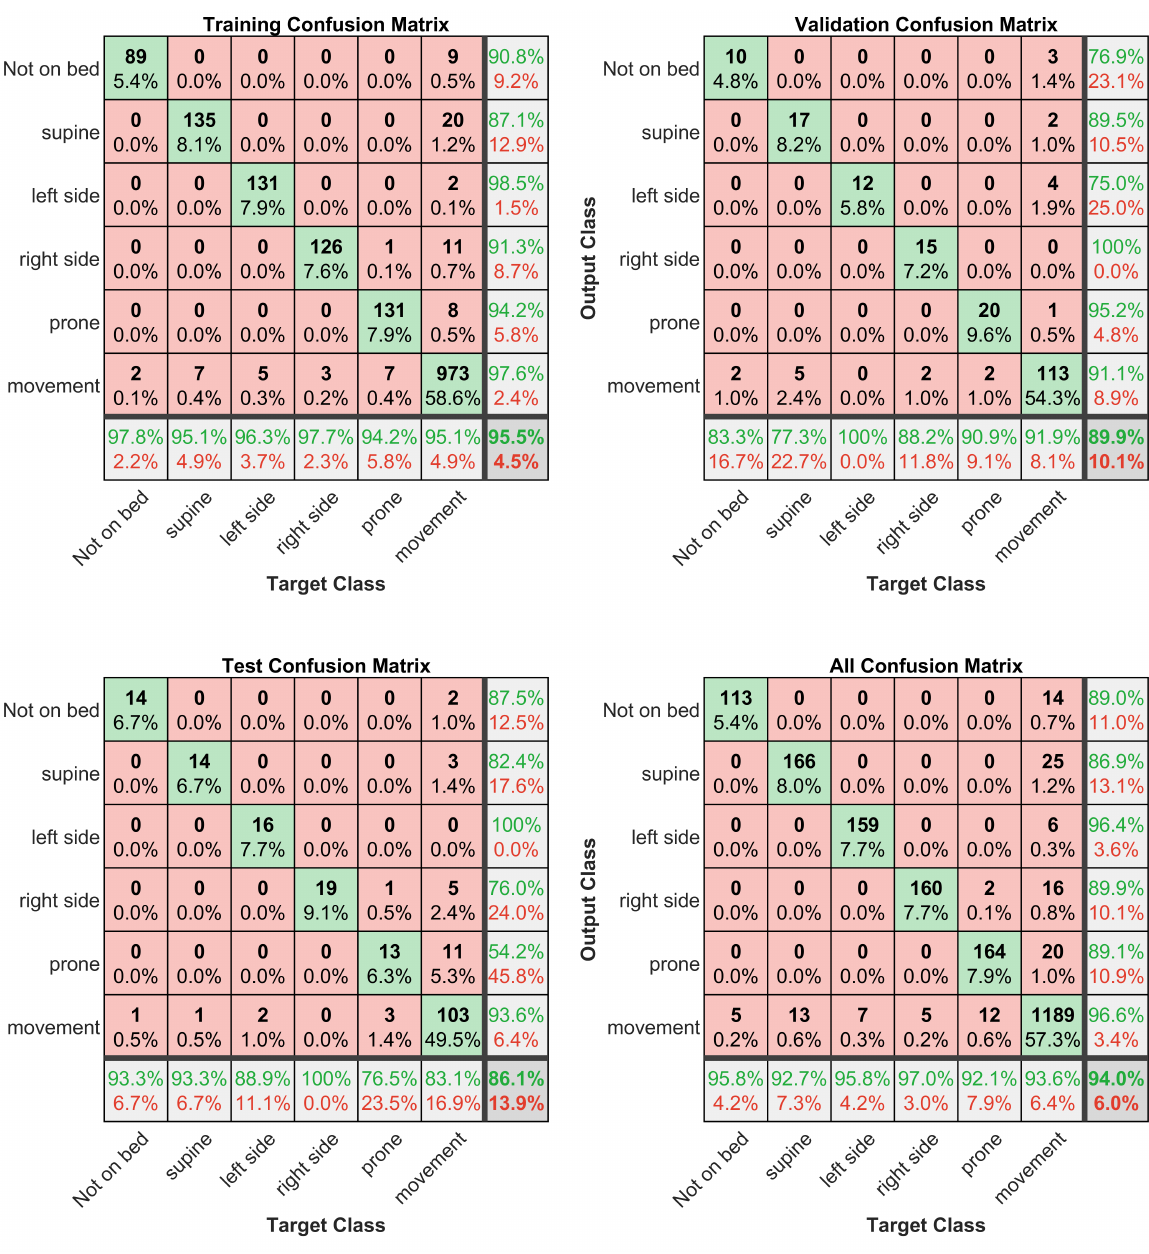
Figure 7. Confusion matrix of the performances of the position classification (Artificial Neural Network (ANN) algorithm), considering the training dataset, the validation dataset, the test dataset, and all datasets. The recognized classes are (i) not on bed, (ii) supine position, (iii) lying on the left side, (iv) lying on the right side, (v) prone position, and (vi)